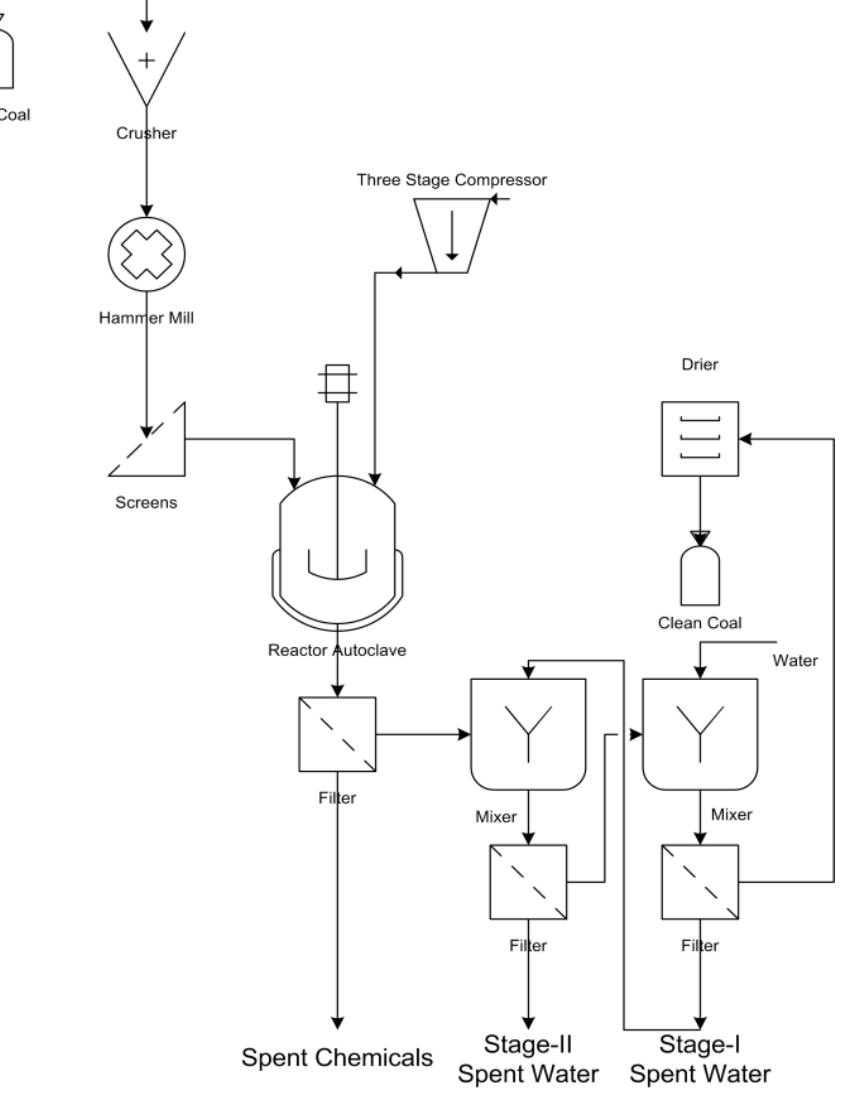
Figure 1. Process flow diagram.